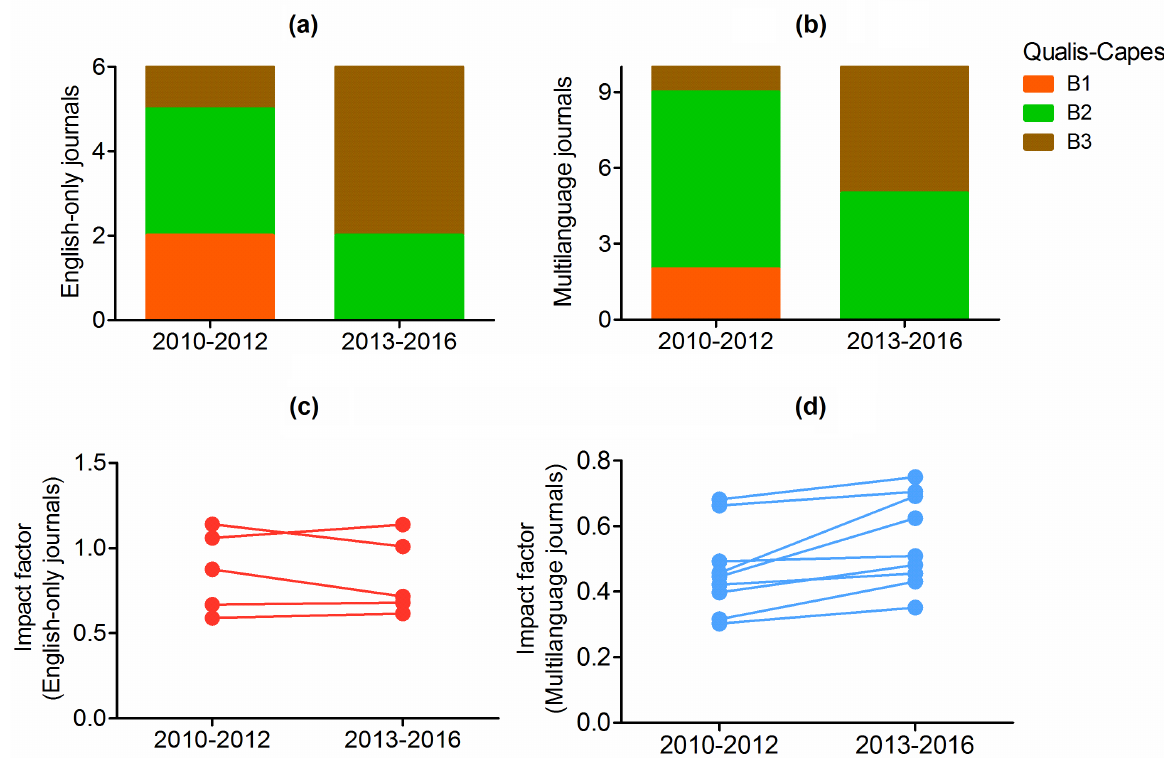
Figure 4. (a-b) Variation in the Qualis-Capes classes over two evaluation periods (2010-2012 and 2013-2016). Most journals were downgraded to B2 or B3 ranks. (c-d) The temporal trend in impact factors (IF) of journals in two evaluation periods. The trend line shows the extent to which IF increased or decreased in both journal types. Each point represents a